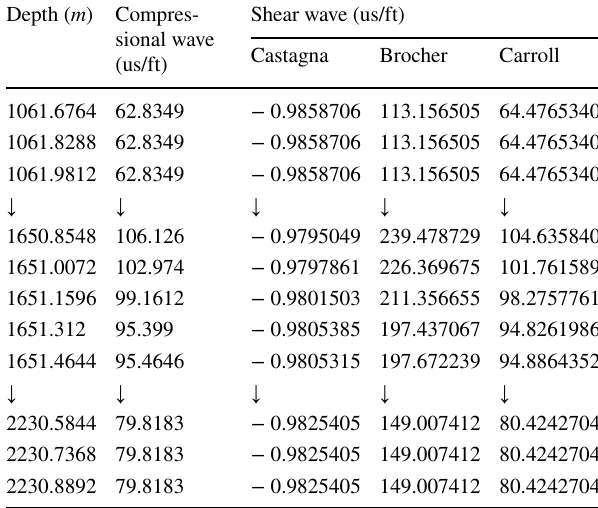
Table 1 Shear sonic wave